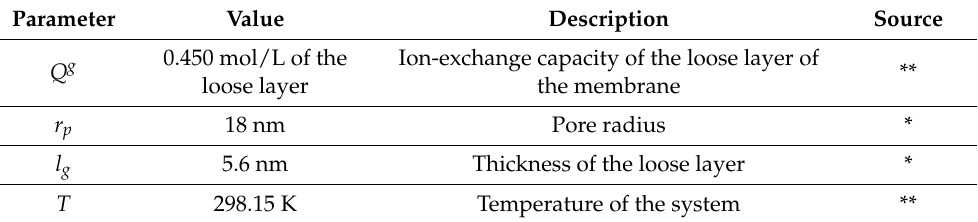
Table 2. Cont. Parameter Value Description Source 0.450 mol/L of the Ion-exchange capacity of the loose layer of Q g ** loose layer the membrane r p 18 nm Pore radius * l g 5.6 nm Thickness of the loose layer * T 298.15 K Temperature of the system